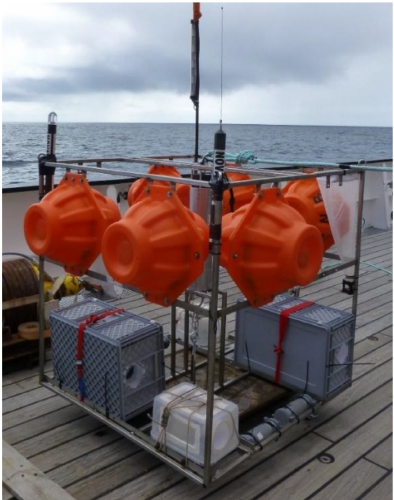
Figure A2. Photograph showing the baited free-fall lander trap de- signed and deployed by RBINS. Equipped with an acoustic release transponder, flashlight, Novotech radio beacon and Posidonia po- sitioning signal to monitor position at the sea floor and ascension through the water column.